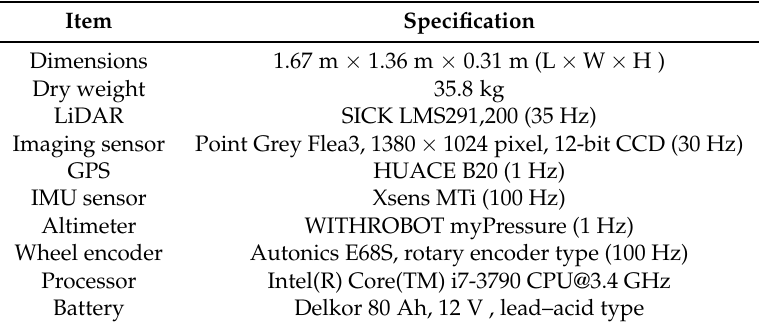
Table 1. Specifications of Urban Mapping System